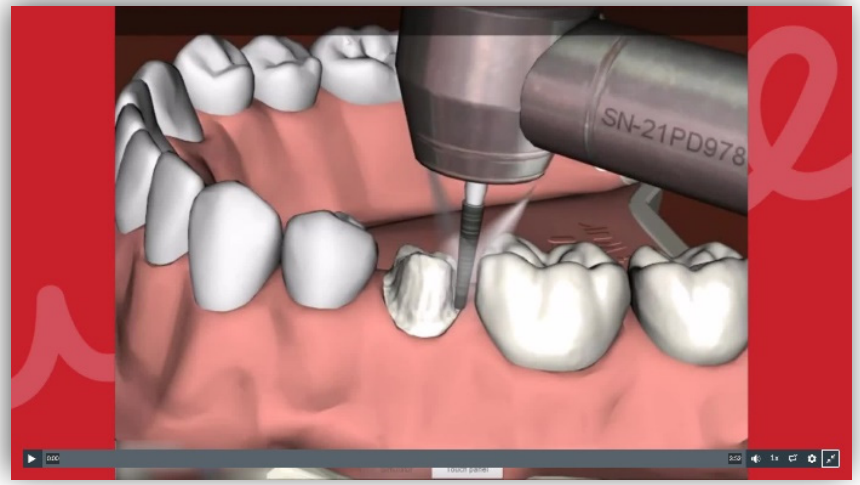
Figure 3. Video tutorial frame. Source: Courtesy of the authors. Written permission of NISSIN Den- tal.